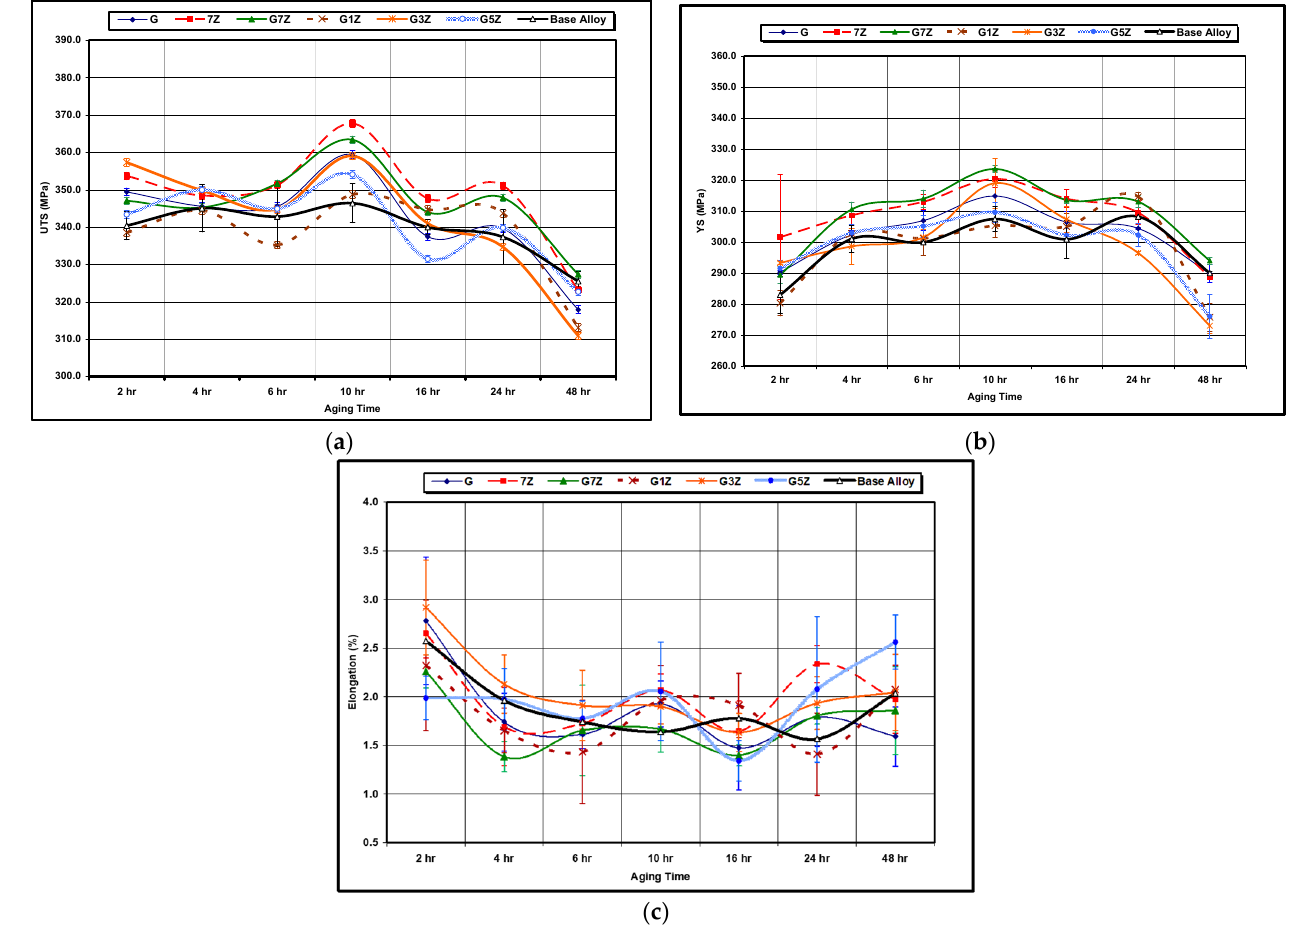
Figure 10. Effect of aging time on the tensile properties of the Zr-Ti alloy group at 180 °C aging temperature: ( a ) UTS, ( b ) YS, ( c ) %El.